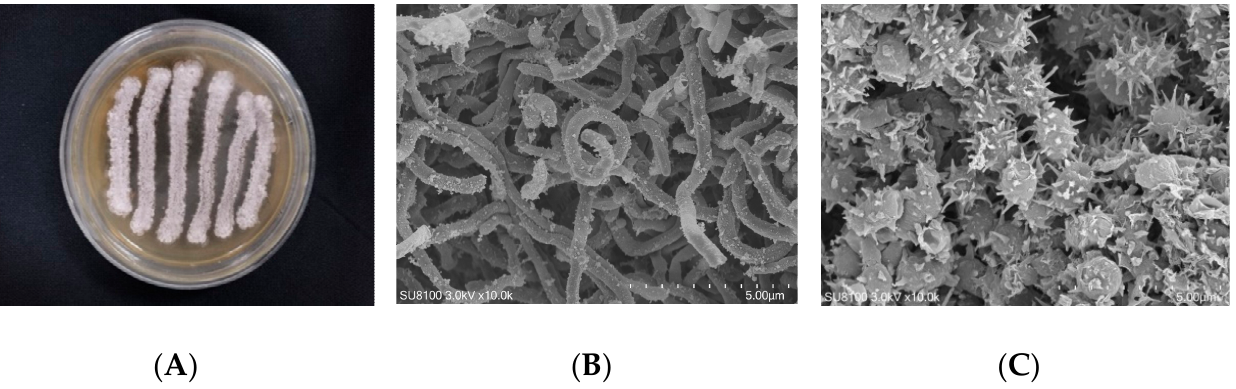
Figure 2. Identification of the strain WS-68302. ( A ) The colonies cultured in ISP-2 for 14 days at 28 ℃ ; ( B ) scanning electron micrograph of the aerial mycelium (bar, 5.0 μ m); ( C ) scanning electron micrograph of the spores (bar, 5.0 μ m).